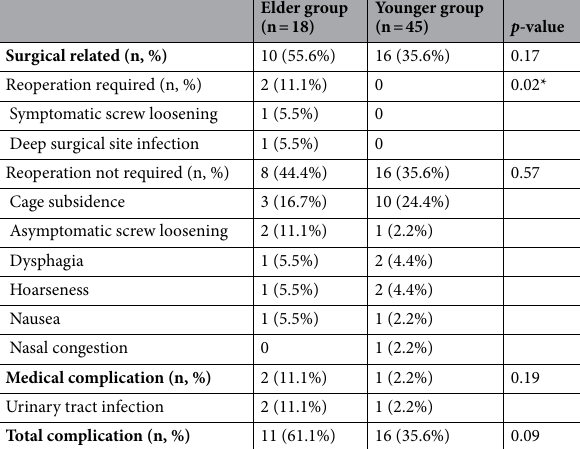
Table 2. Short-term complications (within 1 year). *Statistical significance.